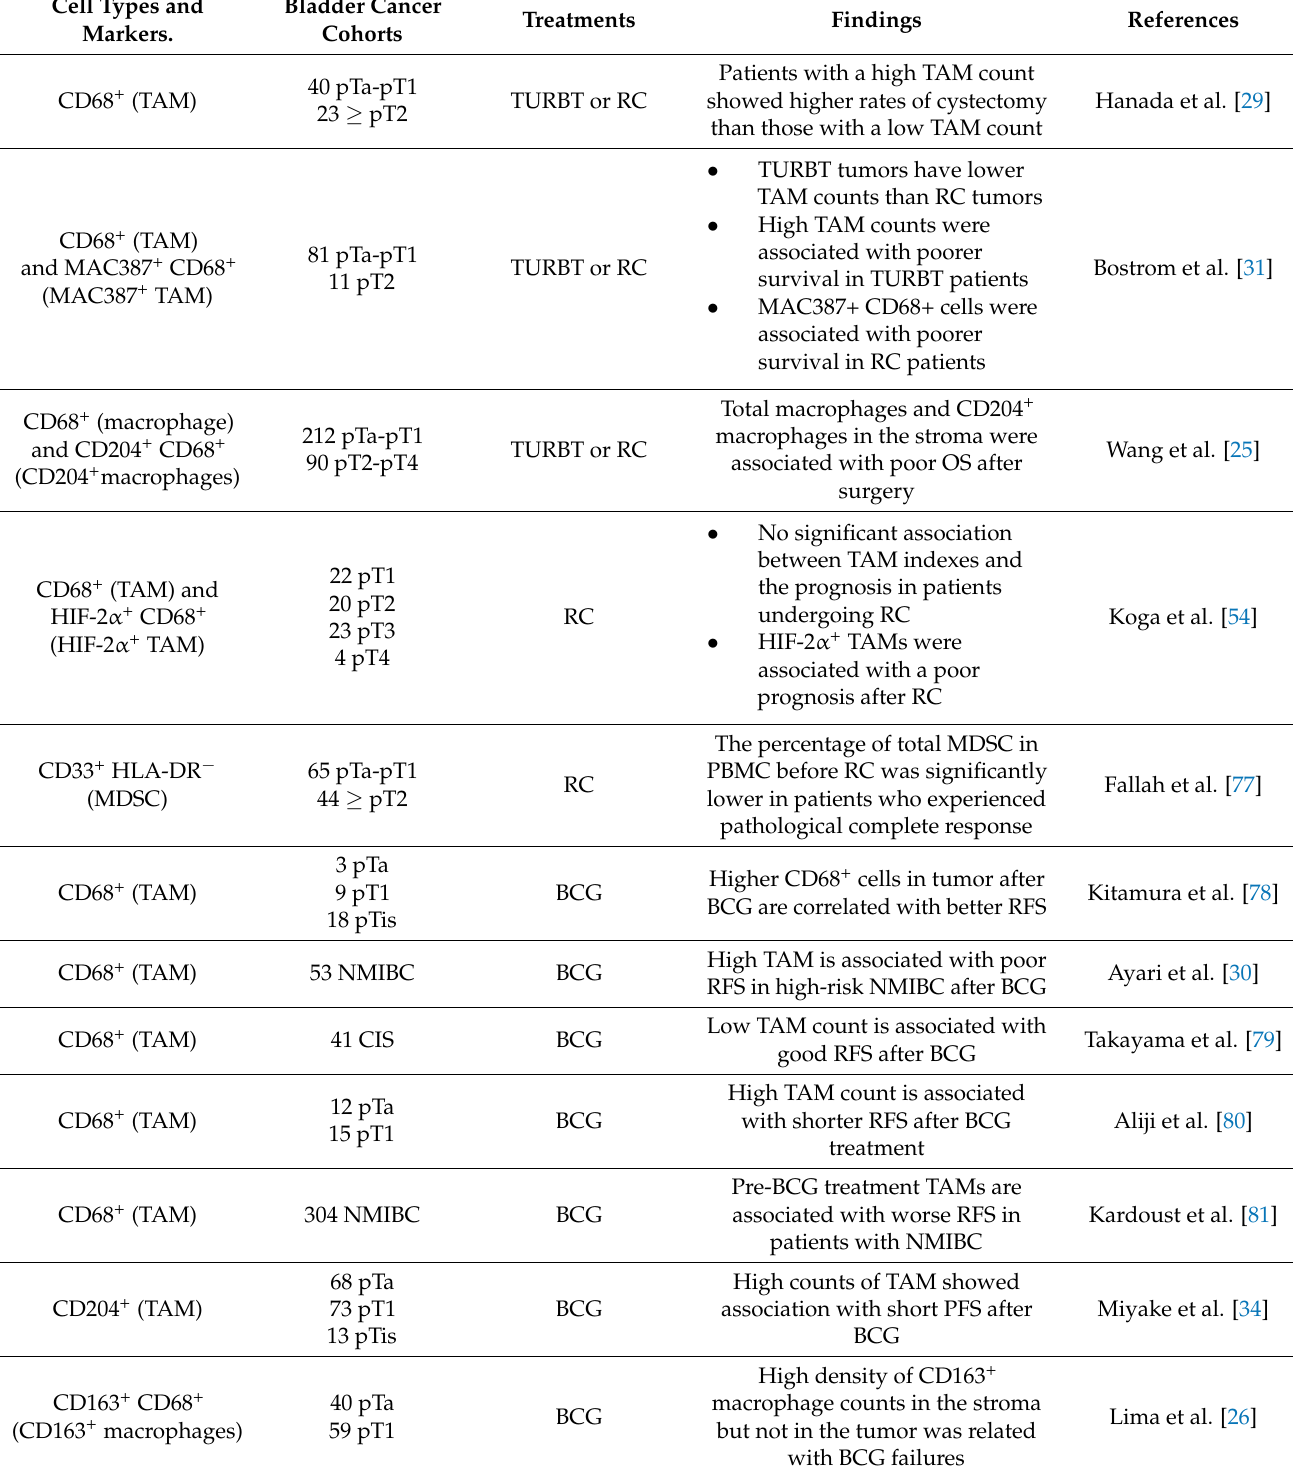
Table 2. Macrophages and responses to bladder cancer